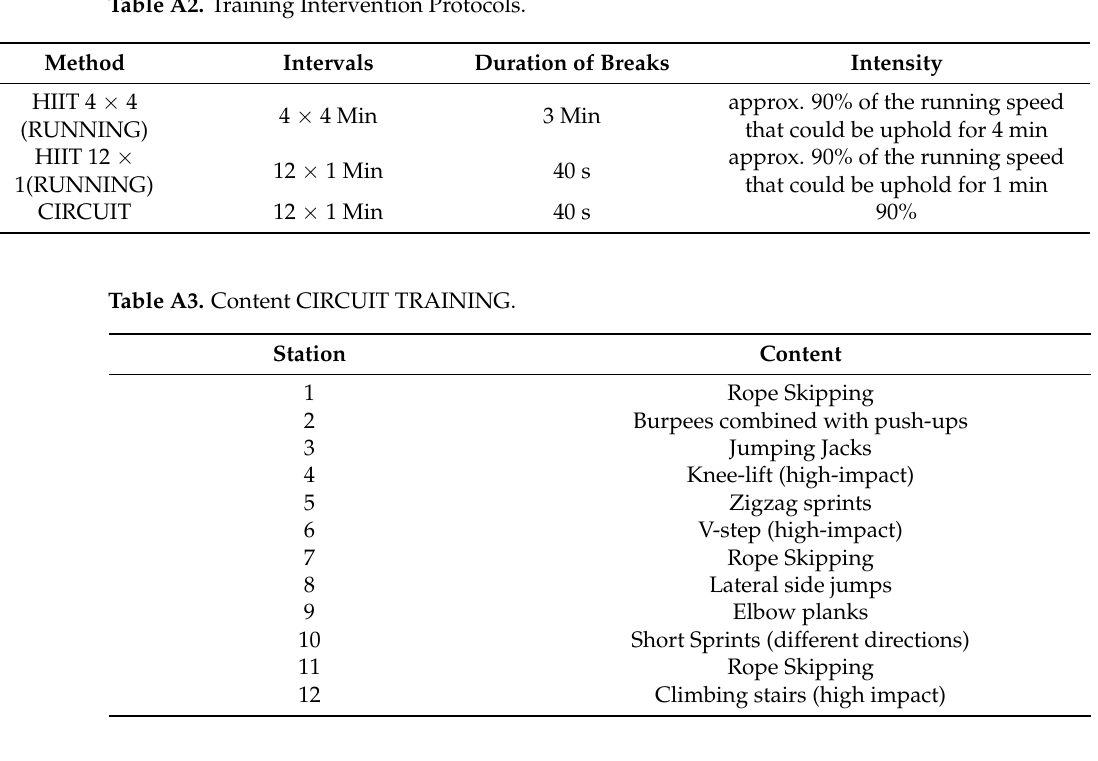
Table A2. Training Intervention Protocols.